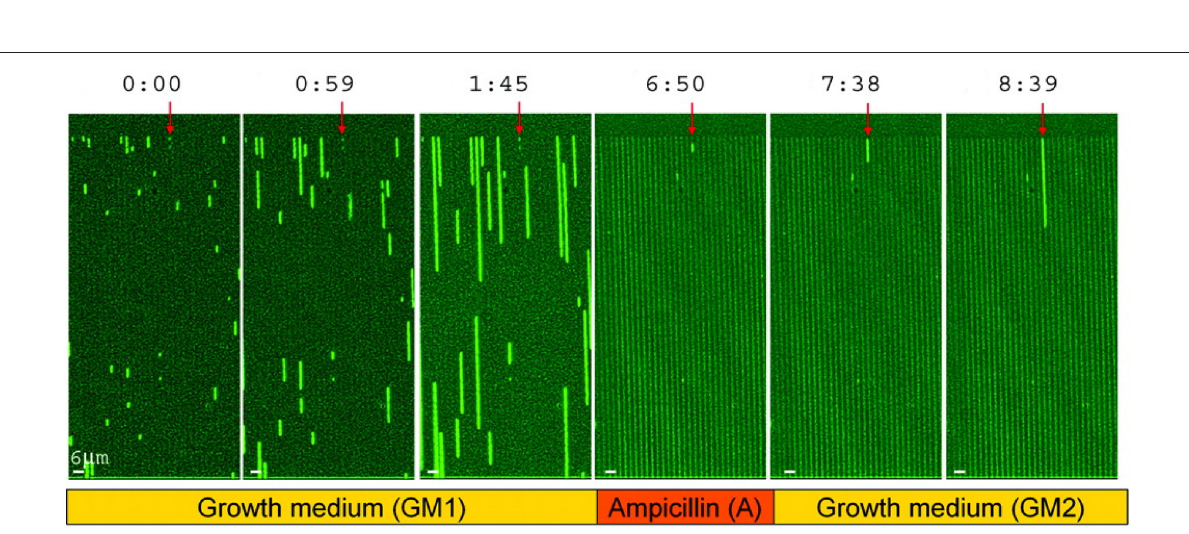
Frontiers in Microbiology |